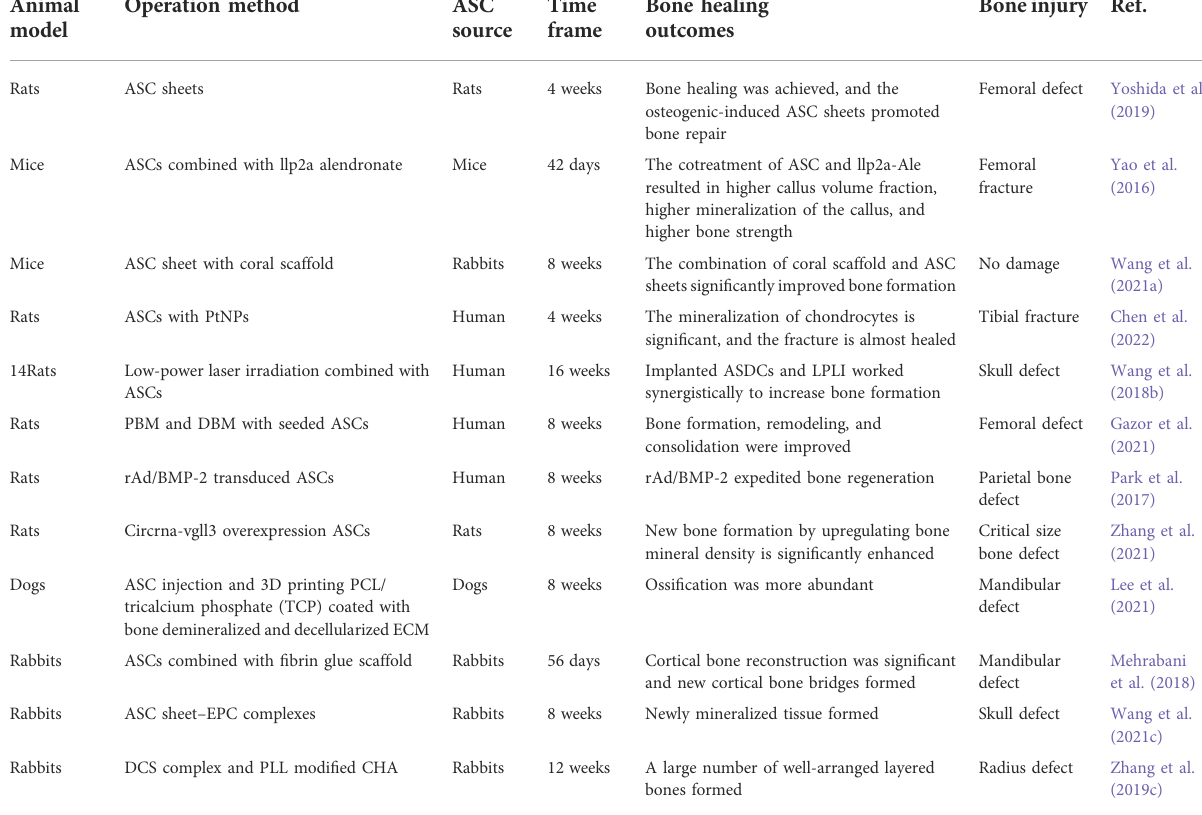
TABLE 1 Relevant animal experiments in recent